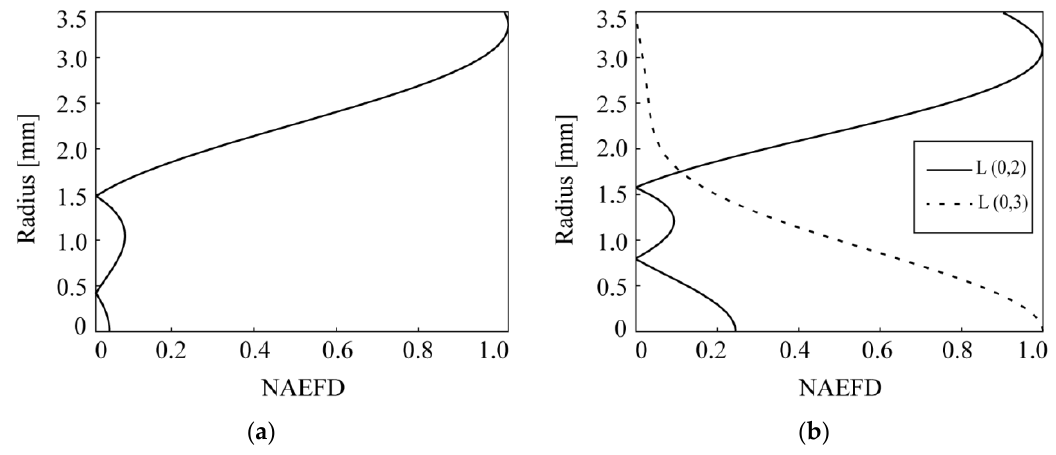
Figure 11. NAEFD radial profile of 7 mm galvanized steel wire. ( a ) Mode L ( 0,2 ) at 700 kHz; ( b ) Modes